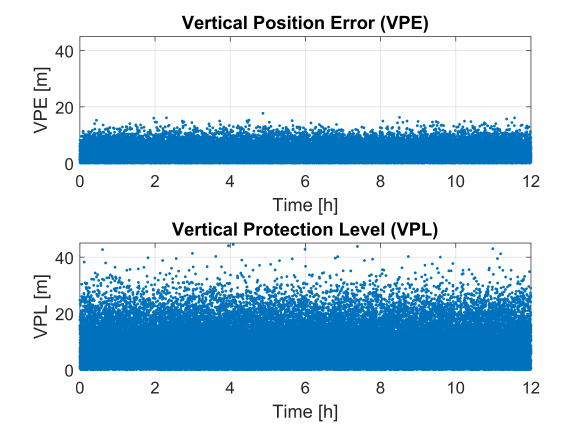
Figure 1. Example time series of simulated vertical position errors (top panels) and protection levels (bottom panel)